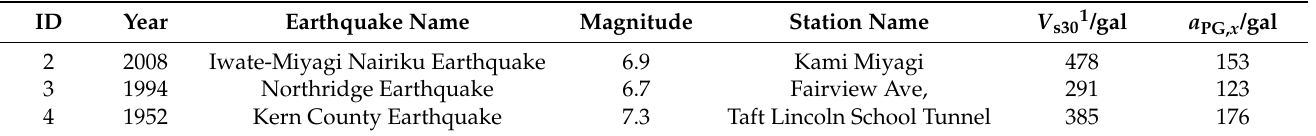
Table 1. Information of natural earthquake waves.